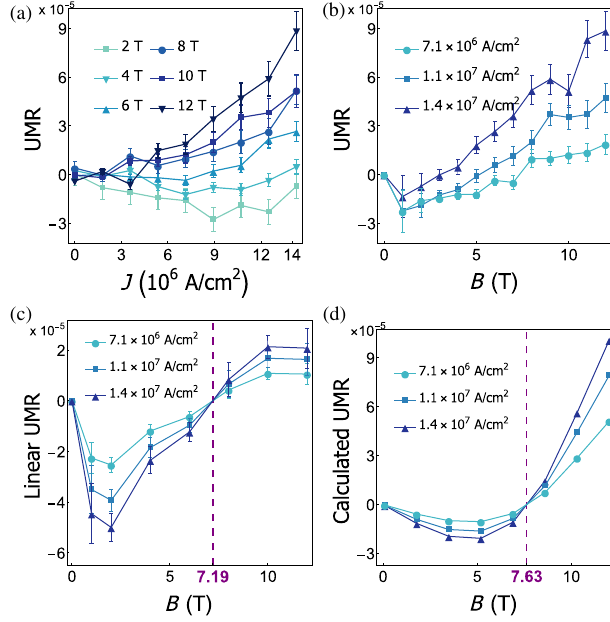
FIG. 2. Magnetoresistance characterization and UMR in the ferromagnetic phase of FeRh = Pt. (a) Temperature sweep of the FIG. 3. UMR in the antiferromagnetic phase of FeRh = Pt. longitudinal resistance under an external in-plane field of (a) UMR in the antiferromagnetic phase of FeRh ½ 110 (cid:2) = Pt as a B ¼ 4 T. Clear transition between the ferromagnetic (FM) phase function of J for various field magnitudes. (b) UMR in the and the antiferromagnetic (AFM) phase is observed. (b) Angular antiferromagnetic phase of FeRh ½ 110 (cid:2) = Pt as a function of field B sweep at T ¼ 10 K (AFM phase) and B ¼ 4 T, under at various current densities J . (c) Extracted linear UMR with J ¼ 1 . 43 × 10 7 A = cm 2 . Δ R is defined as Δ R ¼ R − R respect to the field B , with the purple dashed line indicating the . A av observed field value at which the UMR undergoes a sign change. magnetoresistance which is odd under the current polarity R The observed sign-change field value is 7 . 19 (cid:3) 0 . 17 T (see manifests under high current density. (c) R in the odd odd ; max Supplemental Material Sec. S8 [52]). (d) Calculated UMR in FM phase of FeRh ½ 110 (cid:2) = Pt as a function of J at various field the antiferromagnetic phase as a function of B for different values magnitudes. R is normalized with the base resistance R 0 odd ; max of the applied current, with the purple dashed line indicating the (measured at J ¼ 0 and B ¼ 0 ). Dashed lines show the fitting theoretically predicted field value at which the UMR undergoes a in the FM phase of FeRh ½ 110 (cid:2) = Pt curves α J þ β J 3 . (d) R odd ; max sign change. Parameters used: a ¼ 3 Å, τ ¼ 10 − 14 s, g ¼ 2 , as a function of B at various current densities J . Dashed lines ϵ ¼ 10 eV, ϵ ¼ 0 . 617 ϵ ¼ 0 . 1 ϵ Δ ¼ 0 . 05 ϵ show the fitting curves α B − p þ β . 0 0 , t 0 [55], 0 F ex ¼ α ¼ 11 . 83 T (corre- =a ¼ 0 . 05 ϵ 0 [55,57], H [55,56], ˜ α R R J ¼ 25 ° at B ¼ 10 T), and width of spectral sponding to θ c function ¼ 0 . 002 ϵ 0